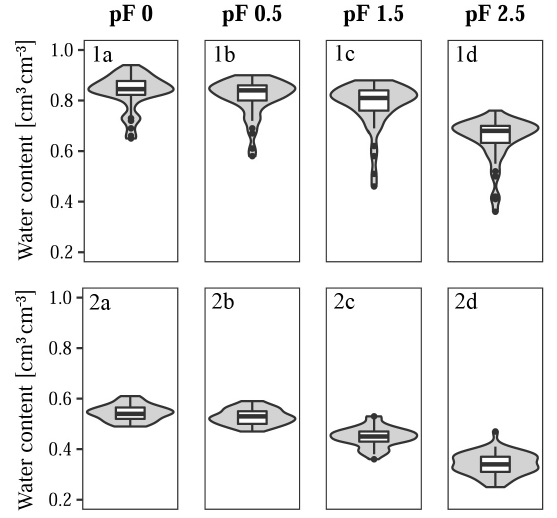
Figure 5. Response variables for (1a–d) Quinuas (46 samples) and (2a–d) Laipuna (51 samples), showing water retention at (1a, 2a) pF 0, (1b, 2b) pF 0.5, (1c, 2c) pF 1.5, and (1d, 2d) pF 2.5. a positive skew. The SOC content is normally distributed and varies between 0.4 wt % and 3.8 wt %. Clay content ranges between 17 % and 48 %, silt ranges between 24 % and 45 %, and sand ranges between 14 % and 50 %. Especially fine values range between 0.25 (pF 2.5) and 0.61 cm 3 cm − 3 (pF